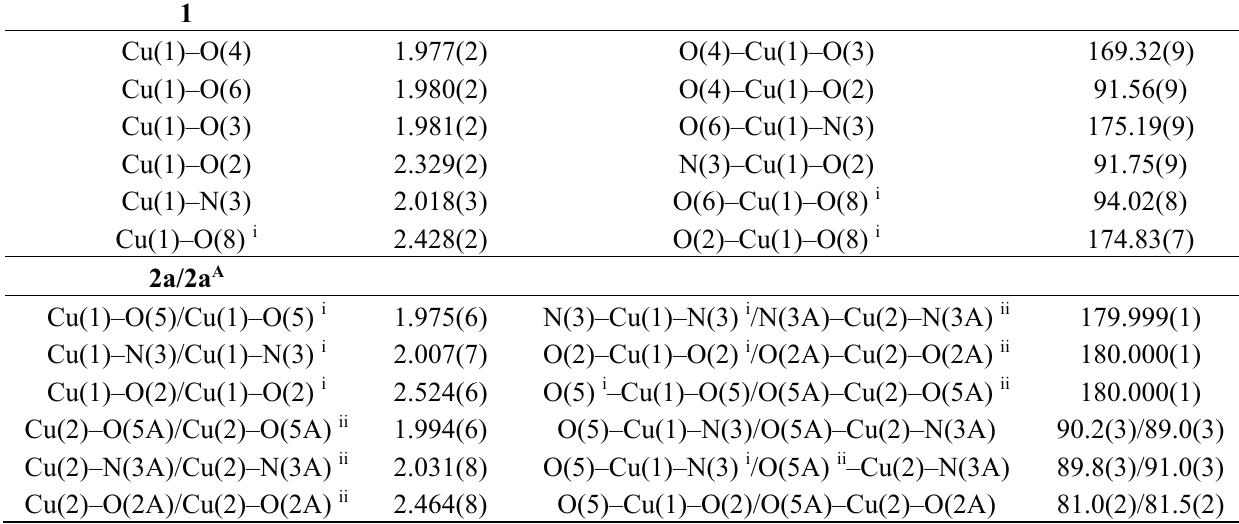
Table 2. Selected bond lengths and angles (Å, °) in complexes 1 and 2a . Data for complex 2a are presented in the following order: 2a/2a A , where 2a A represents the second crystallographically independent molecule within the unit